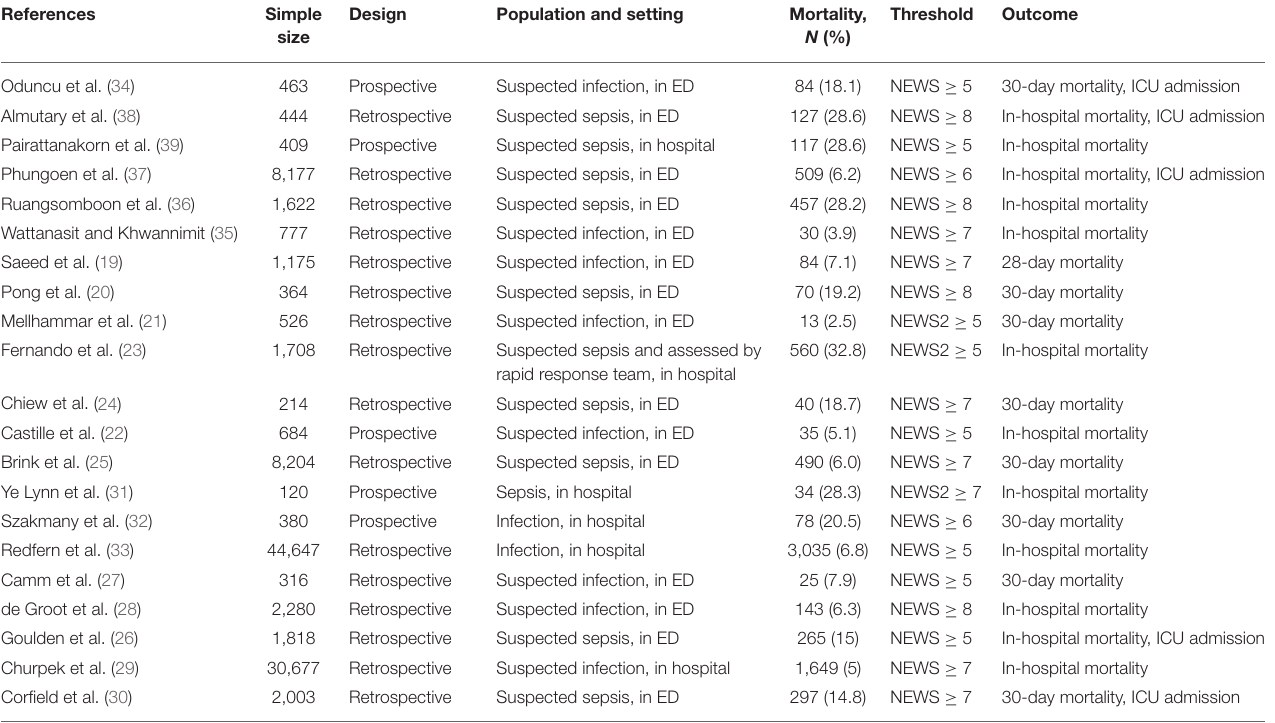
TABLE 1 | Characteristics of included